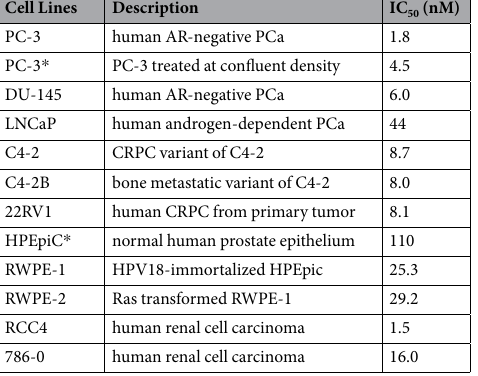
Table 1. Effect of YM155, assayed in dose-response curves (6 to 7 dilutions, 3-fold each), on changes in growth of prostate and renal cell lines after 3 days was assessed by crystal violet staining of adherent cells. IC 50 = half maximal growth inhibitory concentration. * Designates YM155 treatment at near confluent density. The standard errors were < 8% of each of the respective means (n =